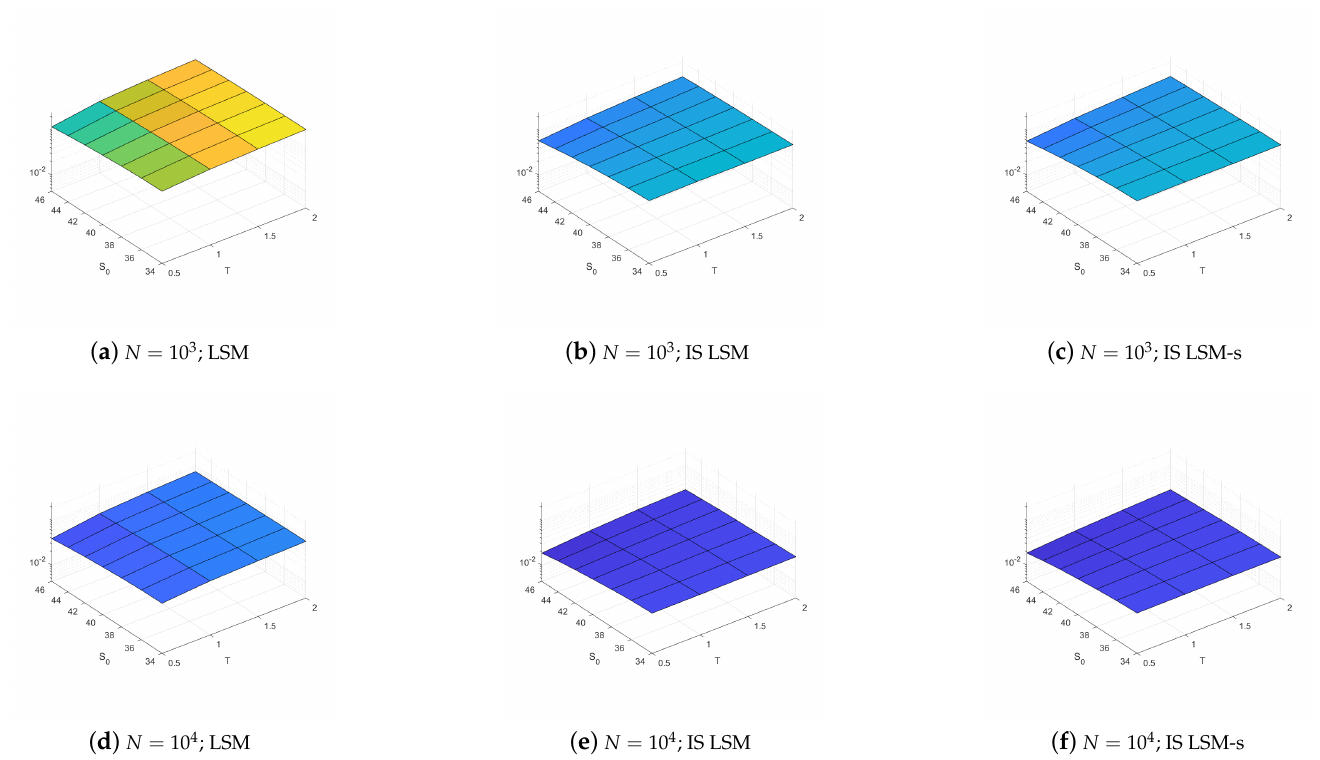
Figure 6. Bias without and with GHS drift. Bias results are calculated with respect to a Cox et al. (1979) binomial tree solution for the LSM and the LSM-s estimators. The left column illustrates results for the LSM without importance sampling, the center column LSM with importance sampling, and the right column LSM-s with importance sampling. The top row presents results for estimators using 1000 paths and the bottom row for 10,000 paths.